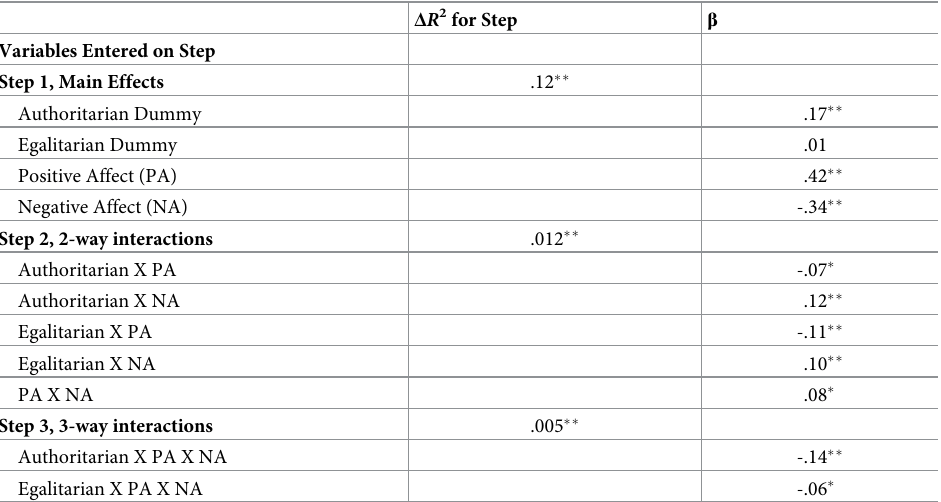
Table 5. Probing moderation of condition effects on meaning in life by